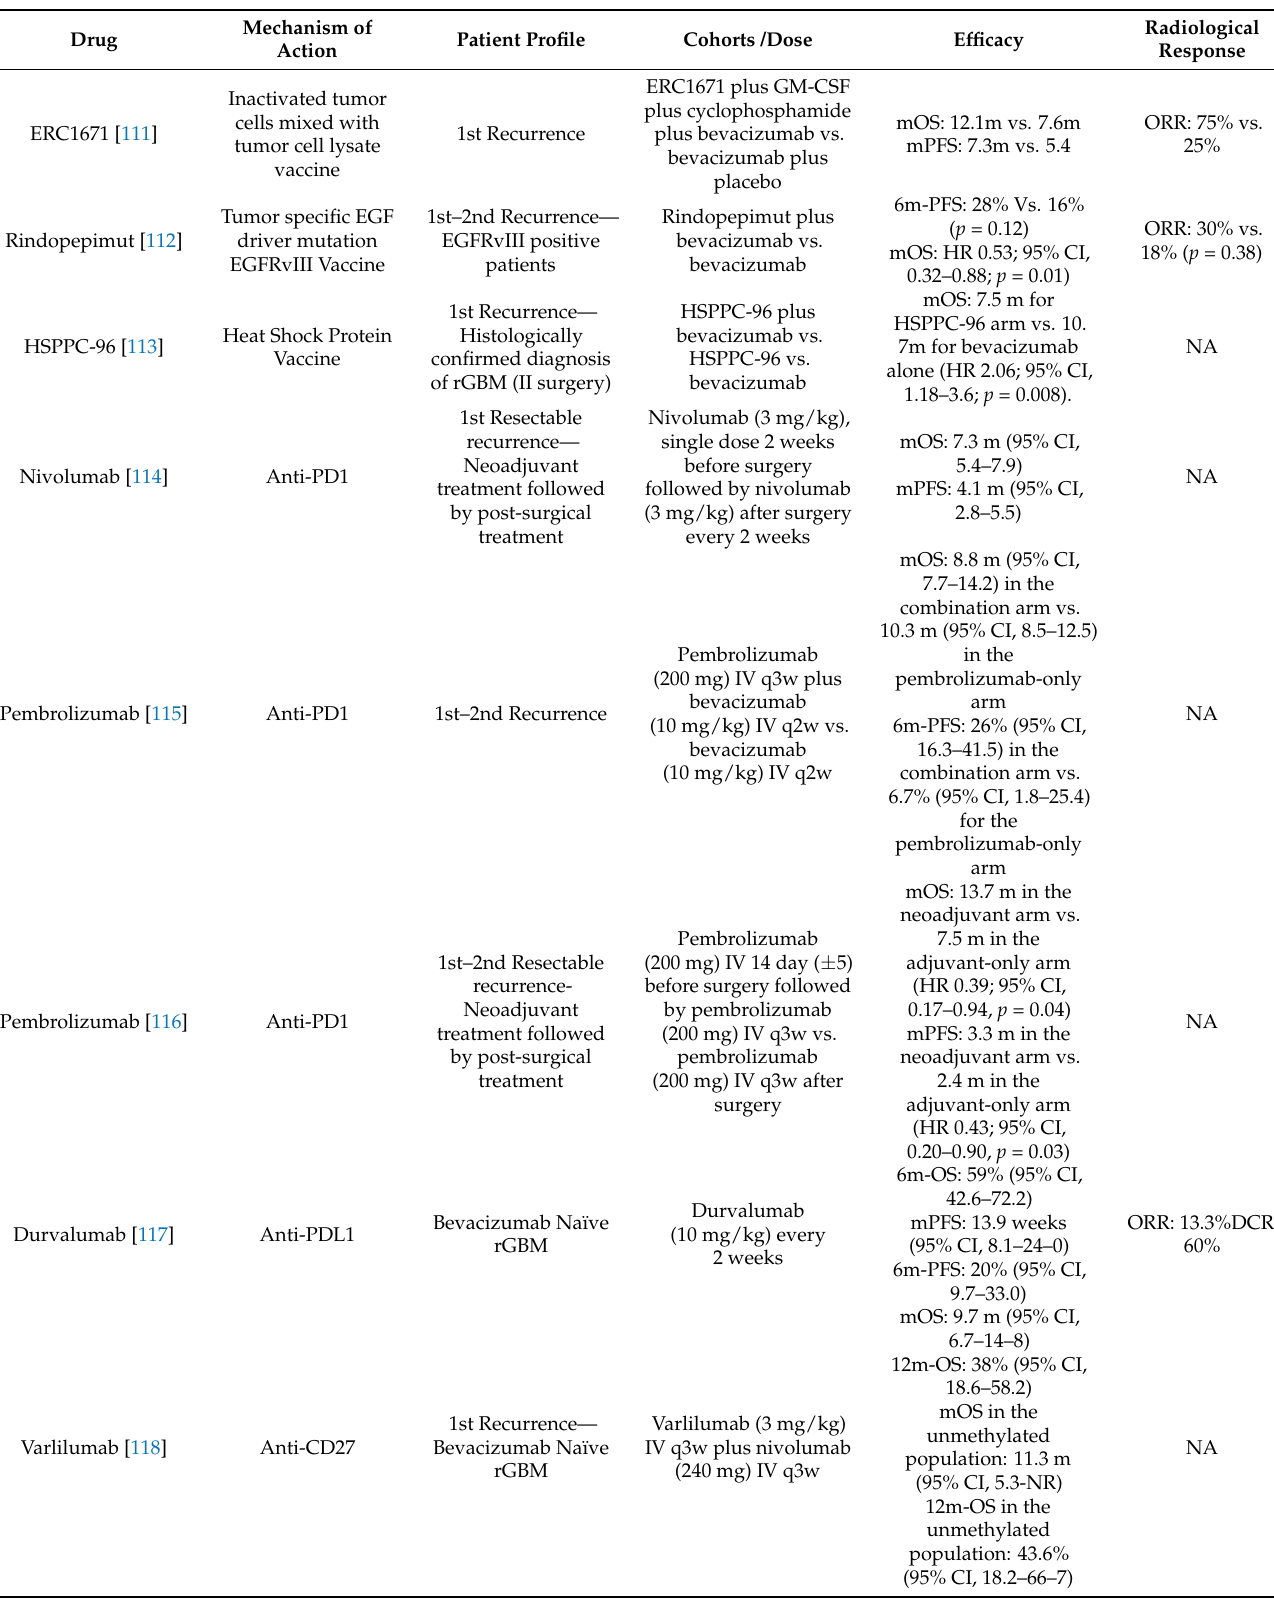
Table 4. Summary of recent phase II immunotherapy